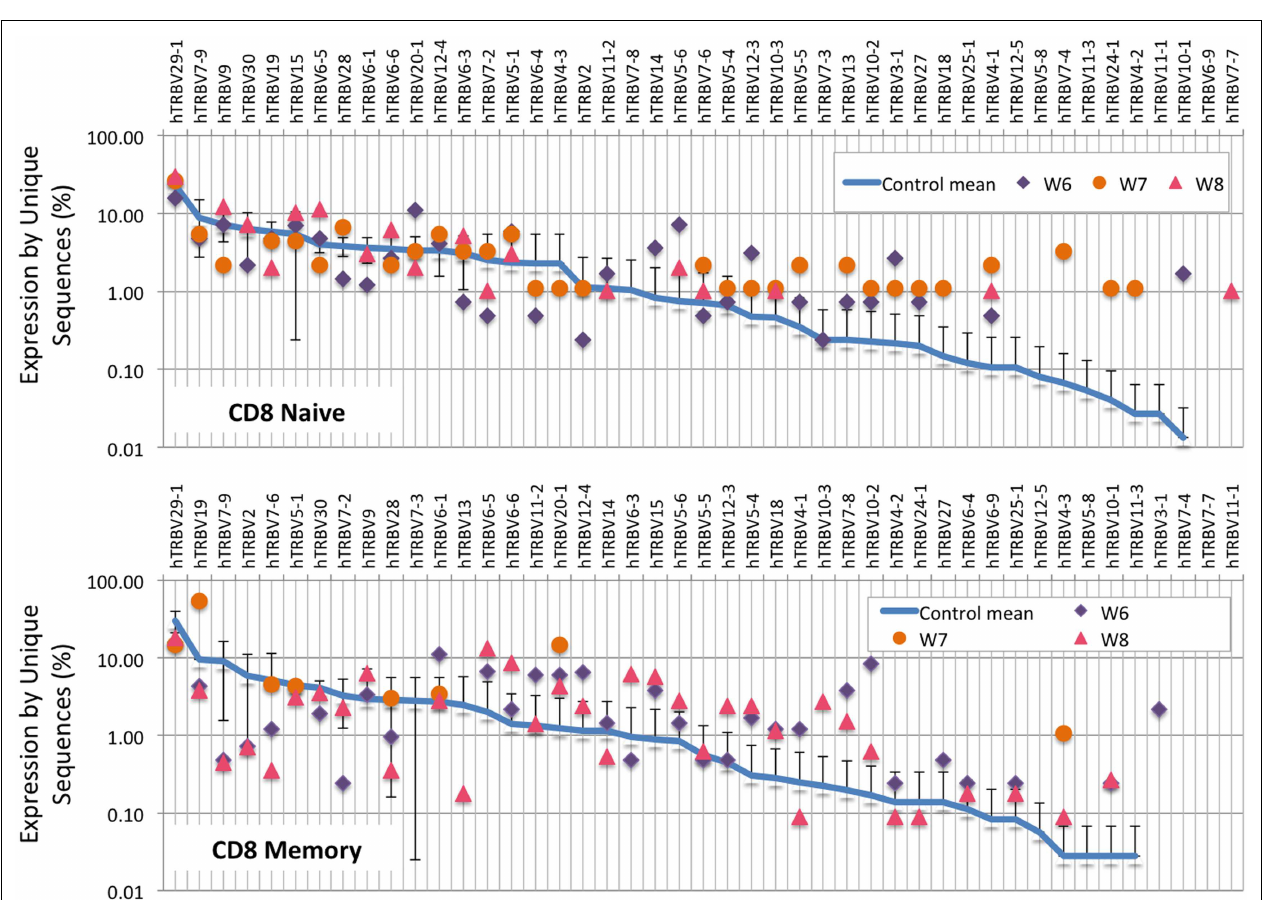
(top panel) or memory (bottom panel) lymphocytes.The blue line indicates the average frequency of the two control patients, and the error bars indicate the SD of the frequency of the